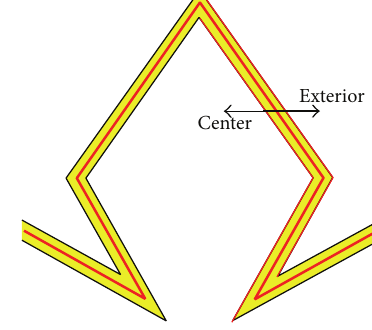
Figure 6: CRA modification.